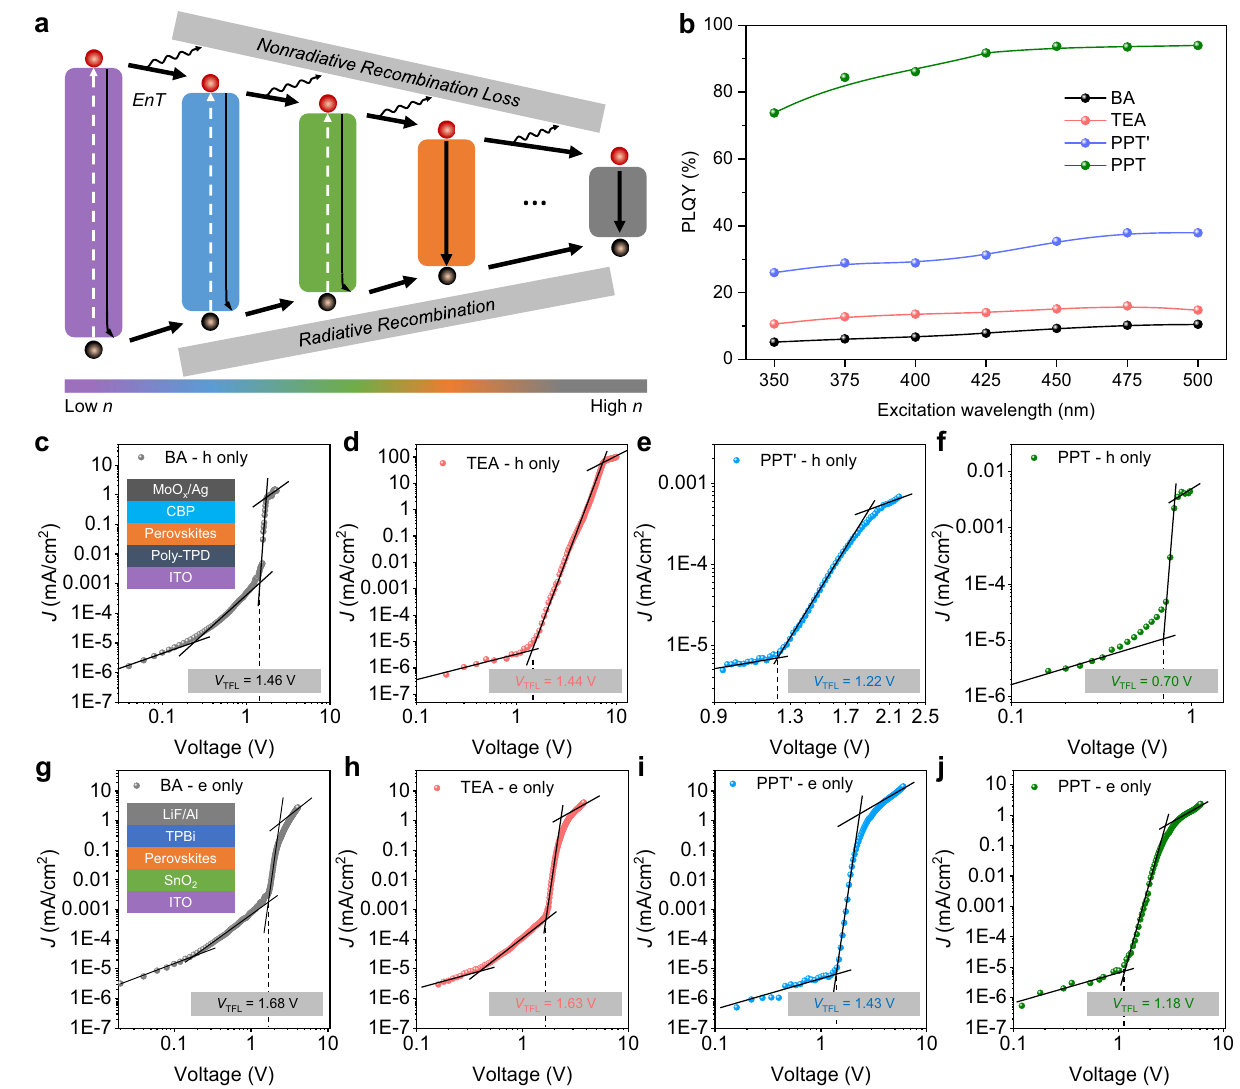
Fig. 3 | Improved optoelectronic properties with better phase control. a Schematic illustration of cascaded energy transfer between different n -phases. The energy transfer ( EnT ) in quasi-2D perovskites is usually accompanied with nonradiative losses and undesired radiative recombination losses if without effective phase distribution control. b Excitation wavelength dependent PLQY of BA(black),TEA(red),PPT ’ (blue),and PPT(green)basedquasi-2Dperovskite fi lms. c – j , Current density versus voltage curves for hole-only ( c – f ) and electron-only